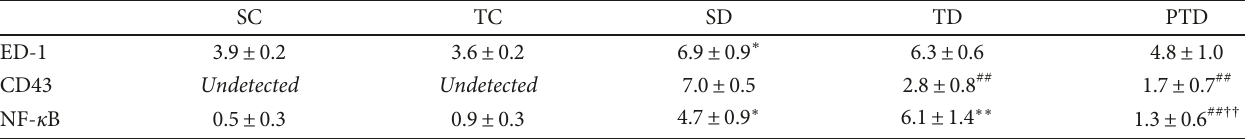
Table 3: Renal immunostaining for ED-1, CD43, and NF- κ B (p65) of SC, TC, SD, TD, and PTD rats.